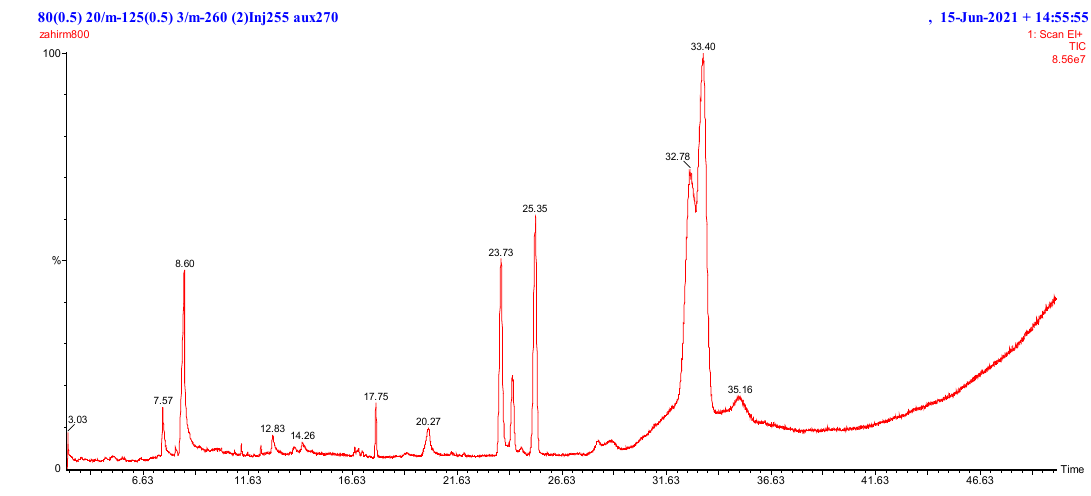
Figure 1. GCMS chromatogram of the M-Ext of peel and kernel extract. Table 1. Identification of compounds in the peel and kernel M-Ext through GCMS analysis.